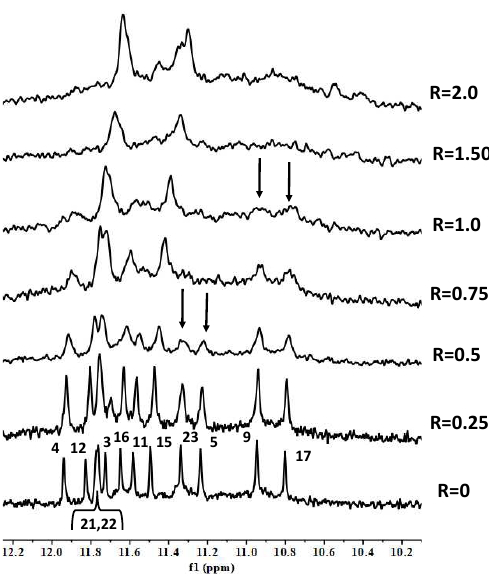
Figure 7. Imino proton region of 1D NMR titration spectra of TP3-T6 with BMH21 at 25 ◦ C at different Figure 7 . Imino proton region of 1D NMR titration spectra of TP3-T6 with BMH21 at 25 °C at differ- R = (drug)/(DNA) ratios. ent R = (drug)/(DNA) ratios.